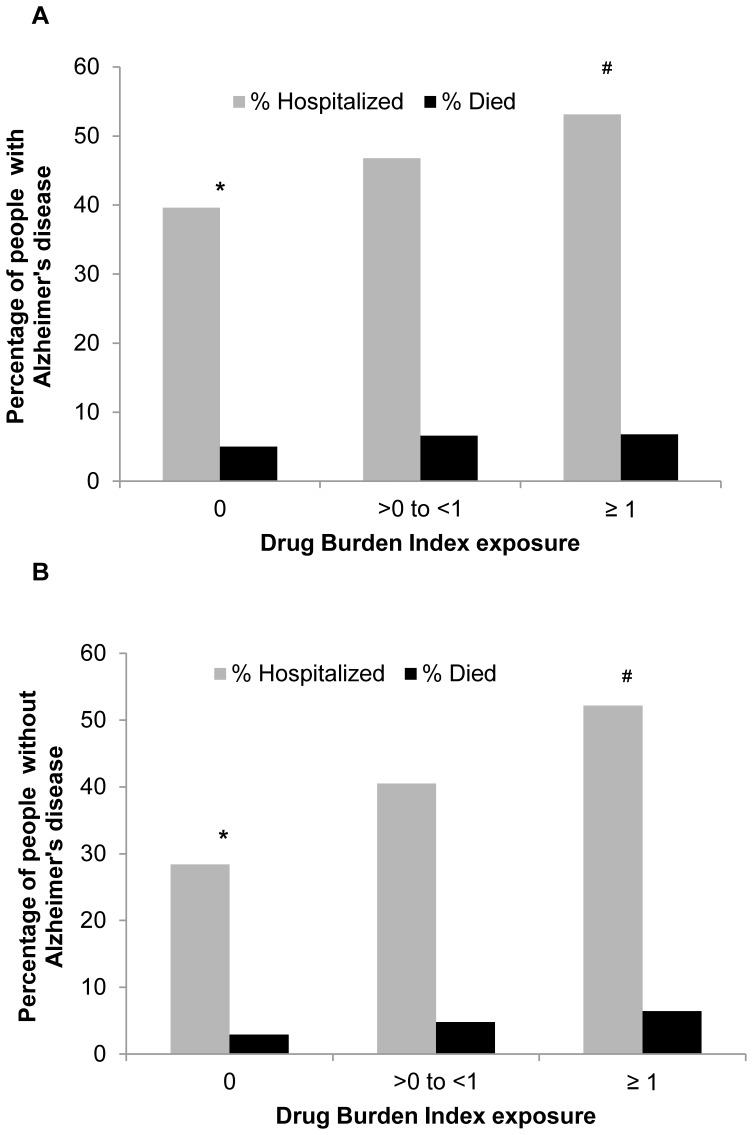
Percentage of people with and without Alzheimer’s disease hospitalized (2A) and died (2B) with increasing Drug Burden Index exposure.*Chi-square tests for differences between the groups: p<0.0001 for hospitalization and death. #Trend test statistics between the groups: p<0.0001.